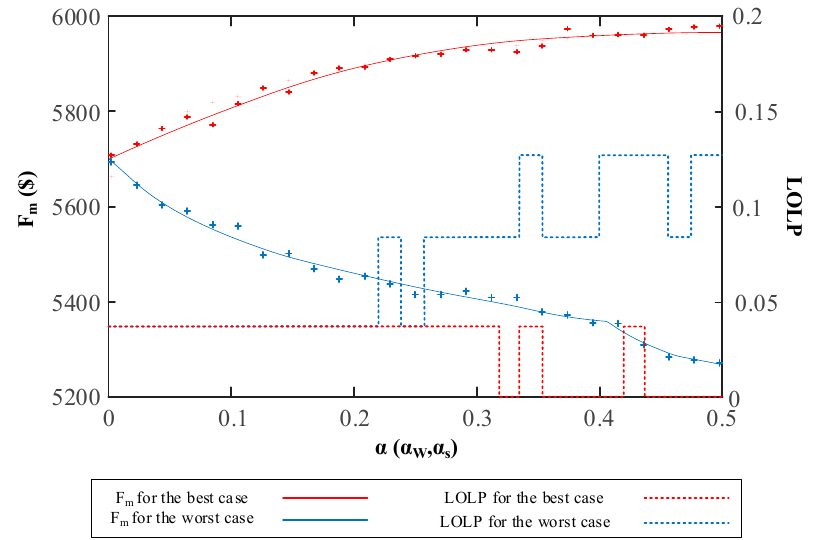
Figure 8. The best-case curves and the worst-cases curve of the system’s average daily generation cost and loss-of-load probability (LOLP) under different renewable energy volatility rates.